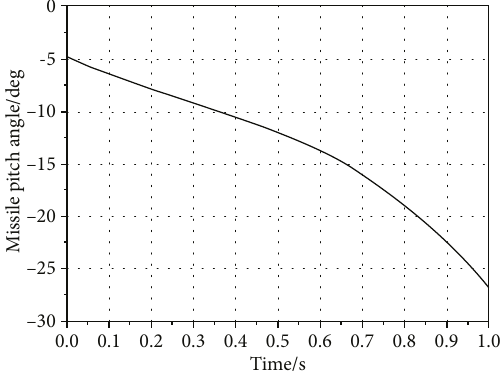
Figure 22: Pitch angle